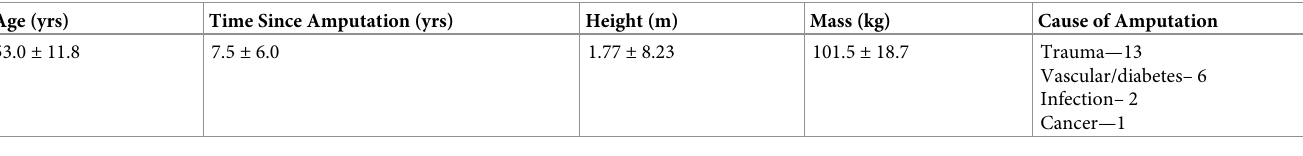
Table 1. Participant demographic